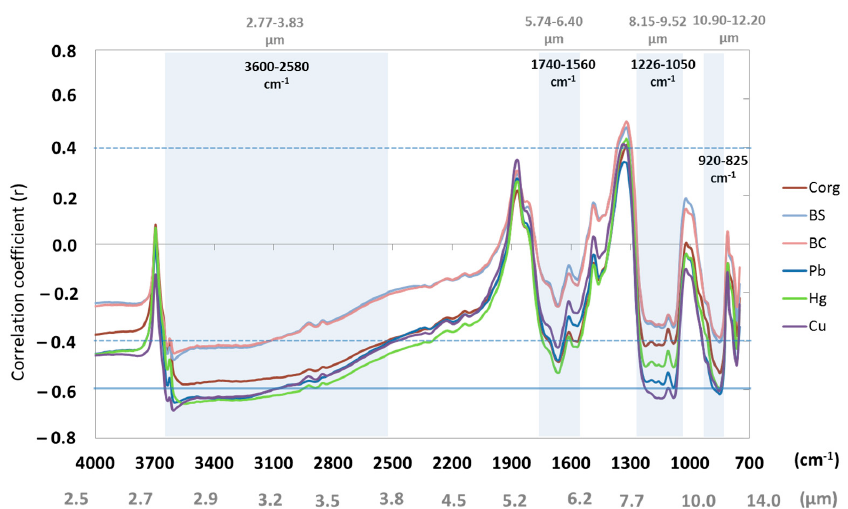
Figure 7. Spectral sensitivity calculated for the FSR spectra MWIR–LWIR range 2.5–13.6 µ m/4000–700 cm − 1 ( y -axes showing the Person’s correlation coefficients). As results published by the scientific community are commonly published on wavelength ( µ m) and wavenumber (cm − 1 ) scales, both scales are used together in this study to make the results comparable and universal.